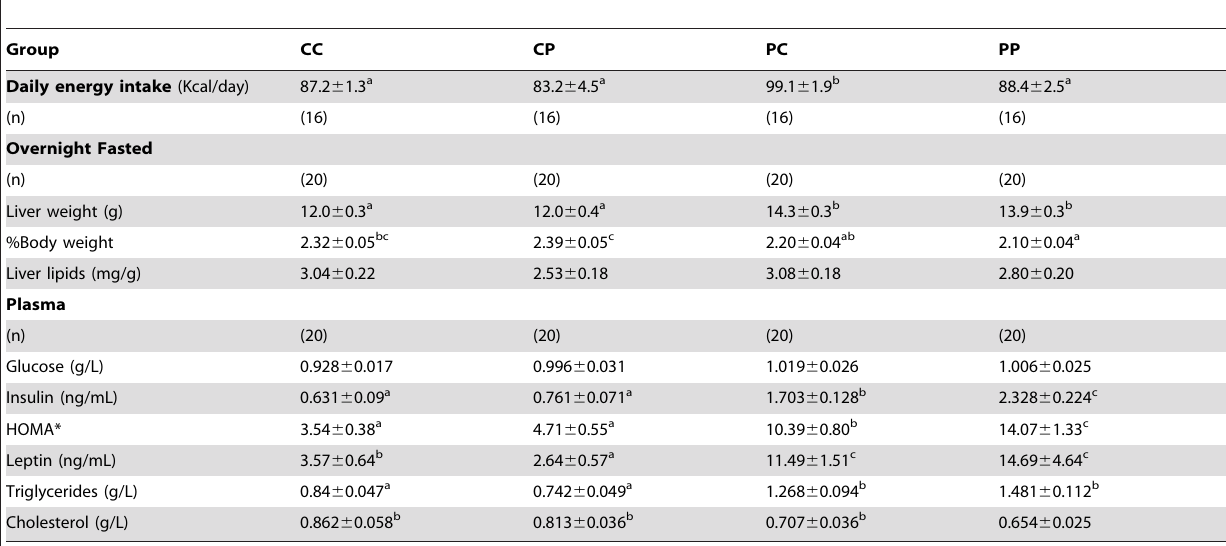
Table 2. Physiological parameters measured in fasted and fed male rats (age: 11 weeks) from 4 experimental groups named according to the post-weaning and maternal chow or palatable diet (C or P as 1 st and 2 nd letter, respectively).